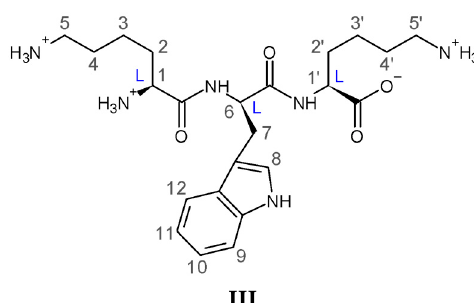
Figure 1. The structural formula of N-acetyl Lys-{L/D-Trp}-Lys peptide ( I , II ) and Lys-Trp-Lys acetate salt ( III ) (counter-ions not shown).